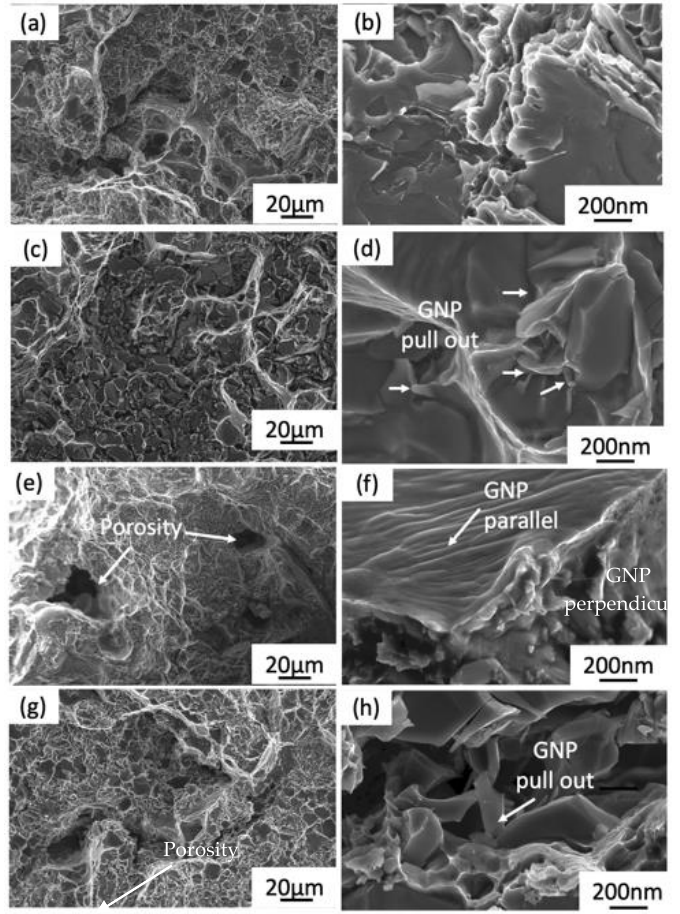
Figure 11. The FESEM fractured surface morphology and high magnification images of the GNPs/Al composites at various graphene contents: ( a , b ) 0 wt.% GNPs; ( c , d ) 0.3 wt.% GNPs; ( e , f ) 0.5 wt.% GNPs; ( g , h ) 1.0 wt.% GNPs.